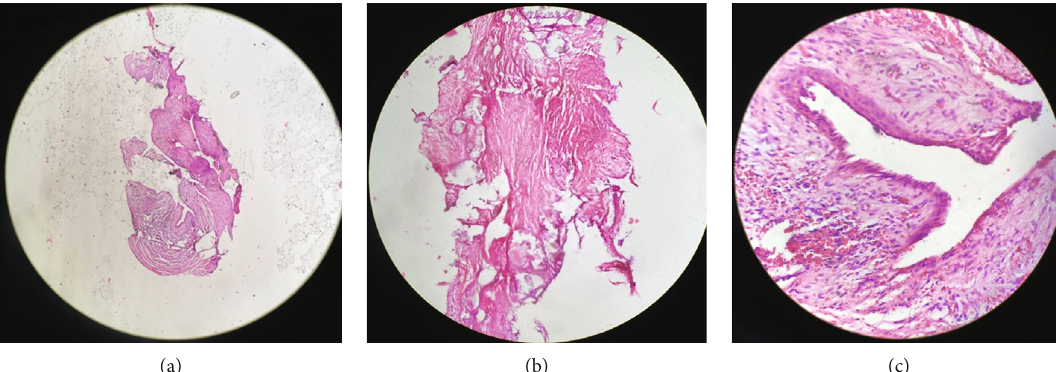
Figure 10: Histopathological examination: (a) showing cyst wall; (b) presence of ghost cells and calci fi cation masses within the epithelium; (c) cuboidal and squamous epithelial